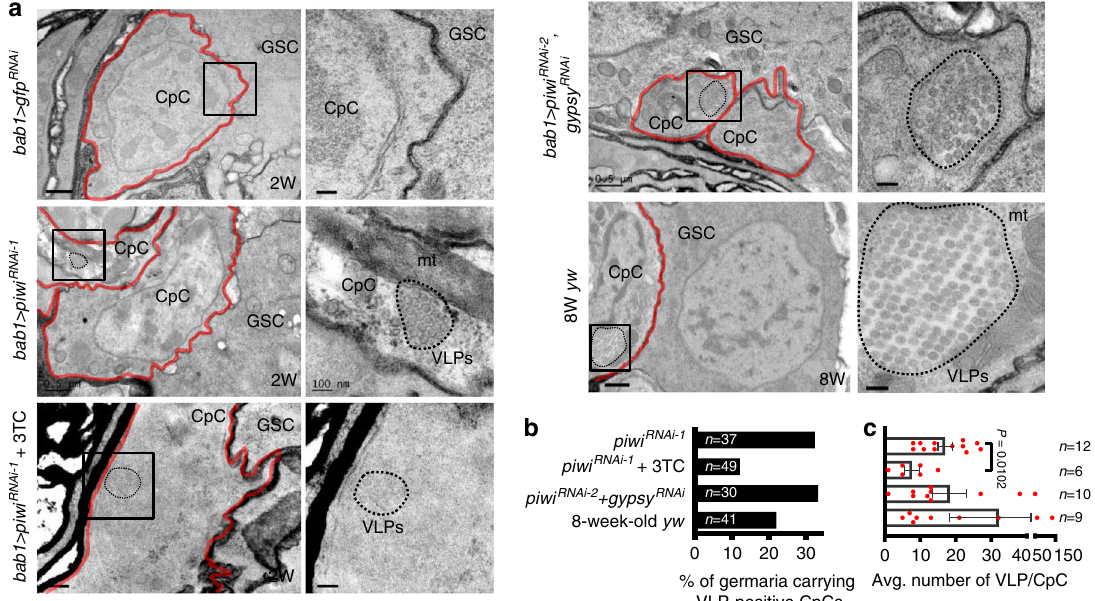
Fig. 5 Retrotransposons generate virus-like particles in Piwi-de fi cient CpCs. a TEM images of anterior germaria of indicated genotype, age and treatment. Right images are enlargements of boxed areas in left images. CpCs red lines, VLPs virus-like particles (black dashed circle), mt mitochondrion. Scale bars, 0.5 μ m for left images, except left image of bab1 > piwi RNAi-1 with 3TC treatment, in which scale bar is 200 nm. Scale bars, 100 nm for all right images. b % of germaria containing VLP-positive CpCs in indicated genotypes. 3TC treatment, but not co-knockdown gypsy , reduced percentage of VLP-positive piwi -KD niche-containing germaria. Examined germaria numbers ( n ) from biologically independent samples are showed inside the bar. c Quanti fi cation of VLPs in TEM sample of indicated genotypes. 3TC treatment reduced VLP number in VLP-positive CpCs. The number of germaria containing VLP-positive CpC from biologically independent samples are showed at the right position of dot plot. Error bars, S.E.M ( c ). Statistical analysis, Student ’ s t -test for c . At least two biological replicates were performed for each